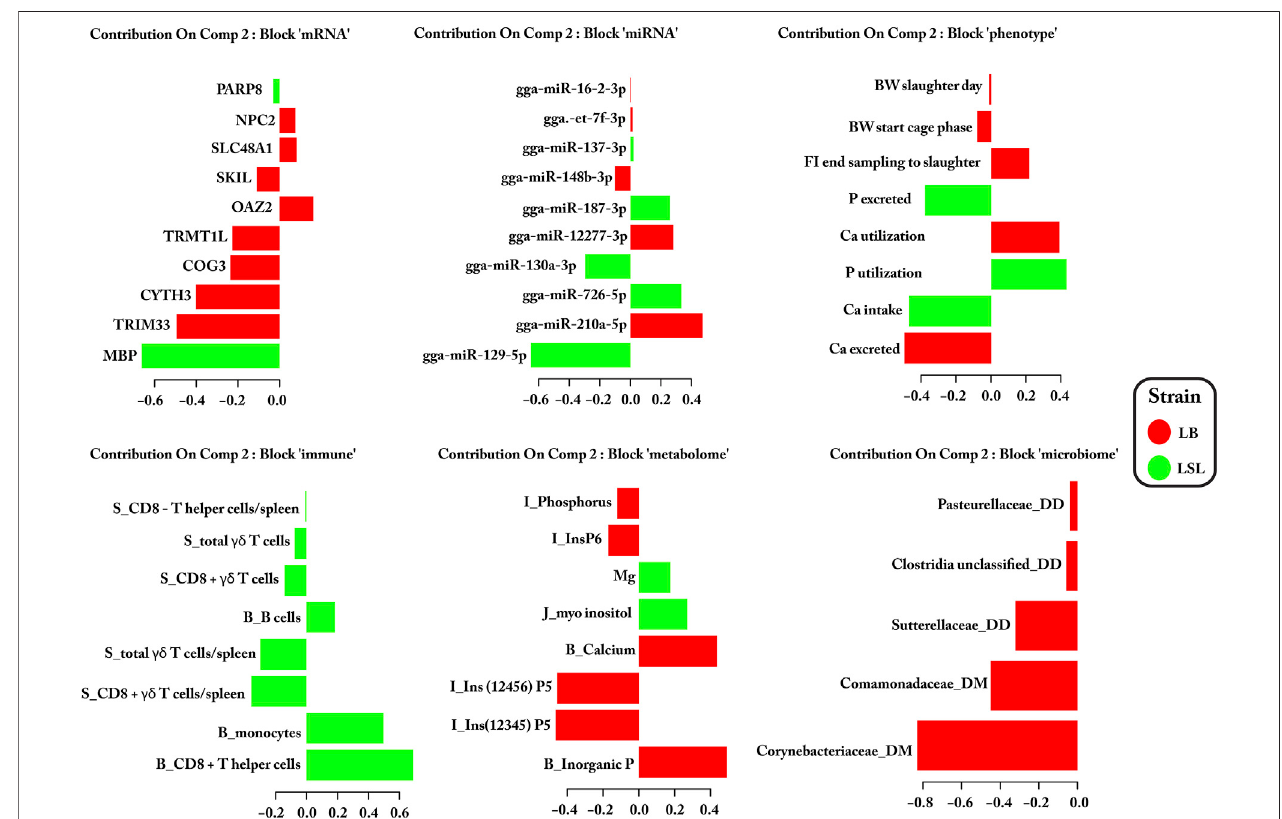
FIGURE 4 | Signi fi cant biomarker loading weights for blocks of miRNAs, mRNAs, phenotypic traits, immune cells, metabolites, and microbes discriminating between LB and LSL over component 2. Barplot names correspond to the feature selected on each block: mRNA, miRNA, phenotype, immune traits [B (blood) or S (spleen) means the original organ from which these immune cells originate], metabolome [I (ileum) or J (jejunum) or B (blood) means the original organ from which these metabolites originate], and microbiota (DDand DM means duodenum digesta and mucosa). The length ofthe bar represented the signi fi cance (loading weights) of the selected features, while the color is related to the strain in which the speci fi c feature is most abundant.